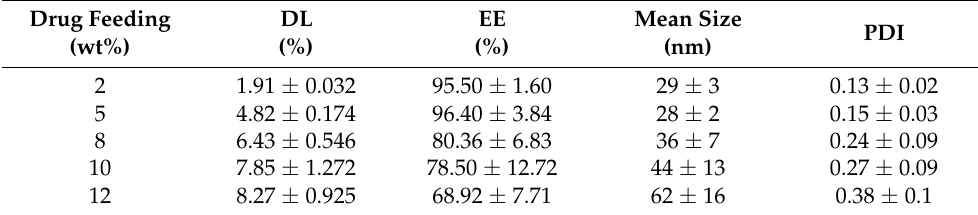
Figure 1. Preparation and characterization of DTX-M. The drug loading (DL) of DTX-M was 5%, and the concentration of DTX was 1 mg/mL (Table 1); photo of DTX-M, blank micelles and N.S ( A ); TEM and size distribution of micelles ( B ); XRD spectra of DTX, DTX with blank micelles, and DTX-M ( C ); the drug release behavior in vitro ( D ); micellar stability in different media by the evaluation of the PDI ( E ) and particle size ( F ) change. (Experiments were performed in triplicate and values were mean ± SEM.) Table 1. Properties of DTX-M with different drug